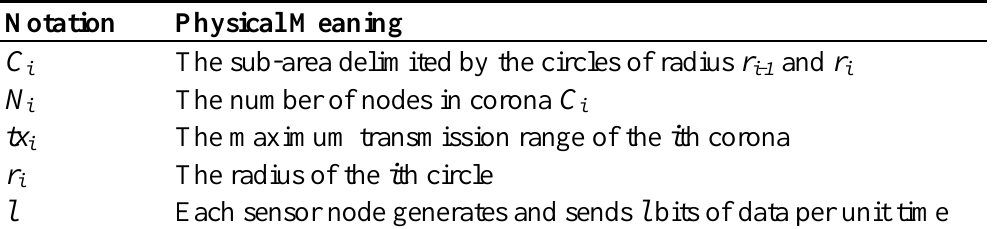
Table 1. The notations used in this